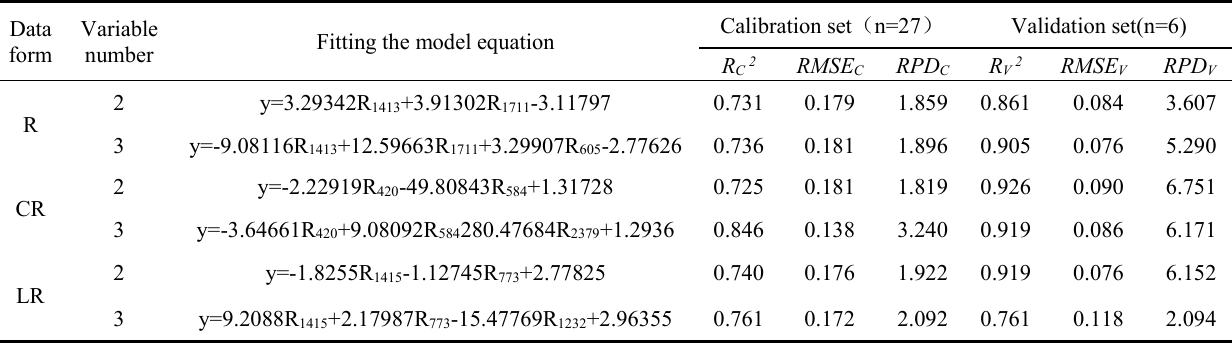
Table6. Multiple Linear Regression model based on a spectral